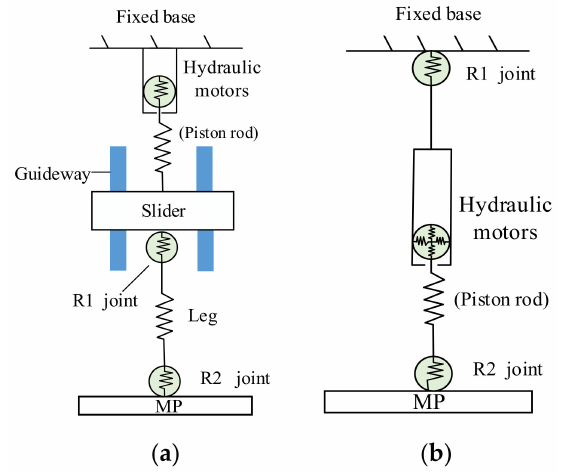
Figure 4. Topology structure of driving chain. ( a ) Topology structure of PRR driving chain; ( b ) topology structure of RPR driving